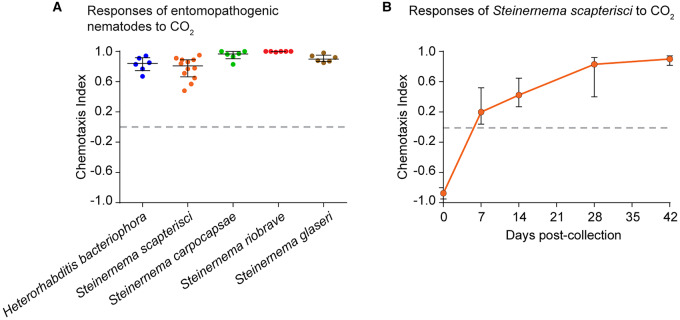
Behavioural responses of entomopathogenic nematodes (EPNs) to CO2. (A) Behavioural responses of the infective juveniles (IJs) of various EPN species to CO2 in a chemotaxis assay (Fig. 1A). All EPNs tested showed attraction to 2.5% CO2. Data are from Dillman et al. (2012b) and Hallem et al. (2011a). (B) Age-dependent changes in the CO2 preferences of Steinernema scapterisci IJs. IJs were grown at room temperature (approximately 22 °C) and then incubated at 15 °C until the indicated time points (days post-collection). CO2 responsiveness changes from repulsion to attraction with age. IJs were tested with 1% CO2. Data are from Lee et al. (2016). The graph shows medians and interquartile ranges.